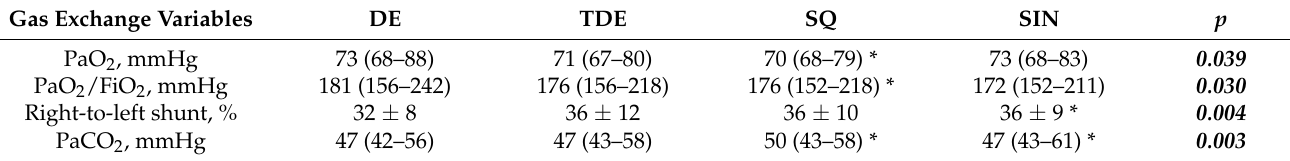
Table 4. Gas exchange and right-to-left shunt according to flow